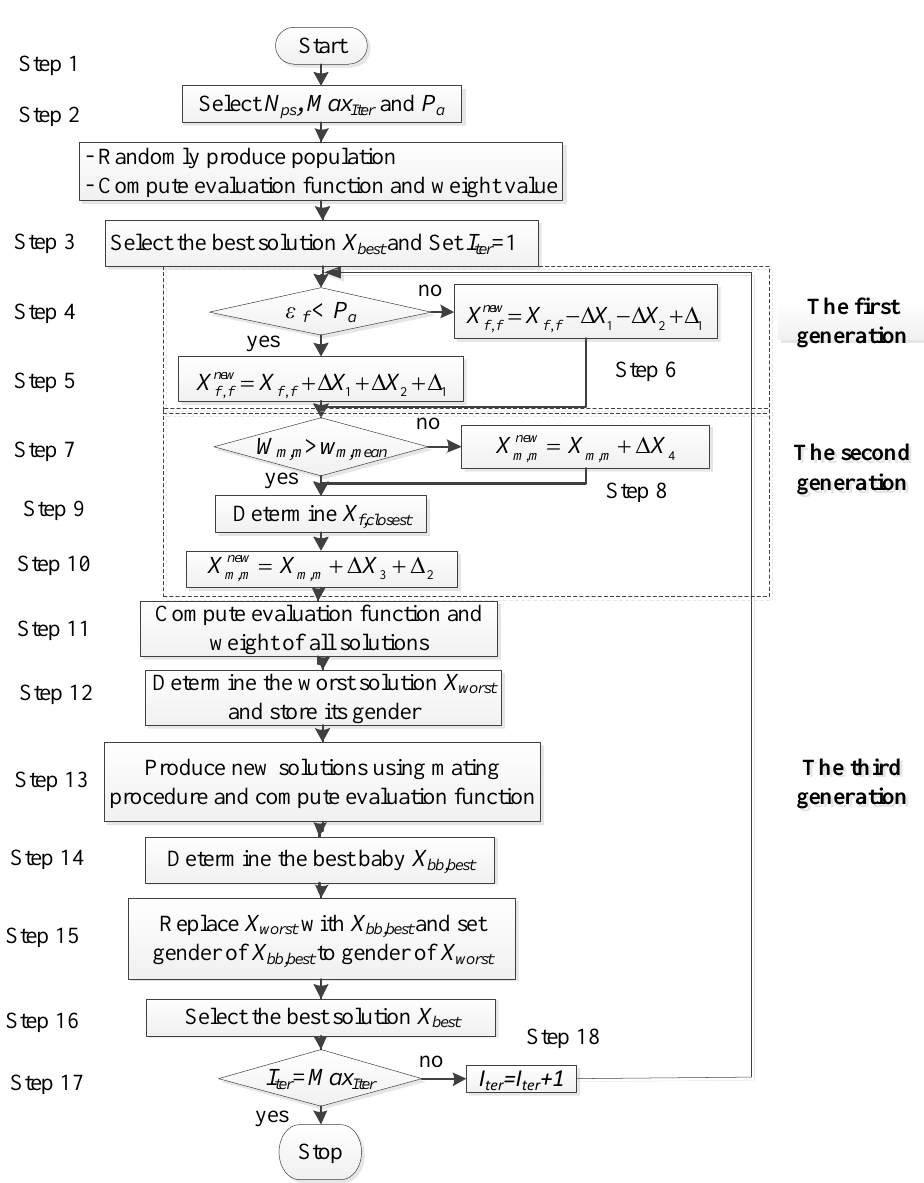
Figure 1. The flowchart of solving a typical optimization problem by using SSSO.